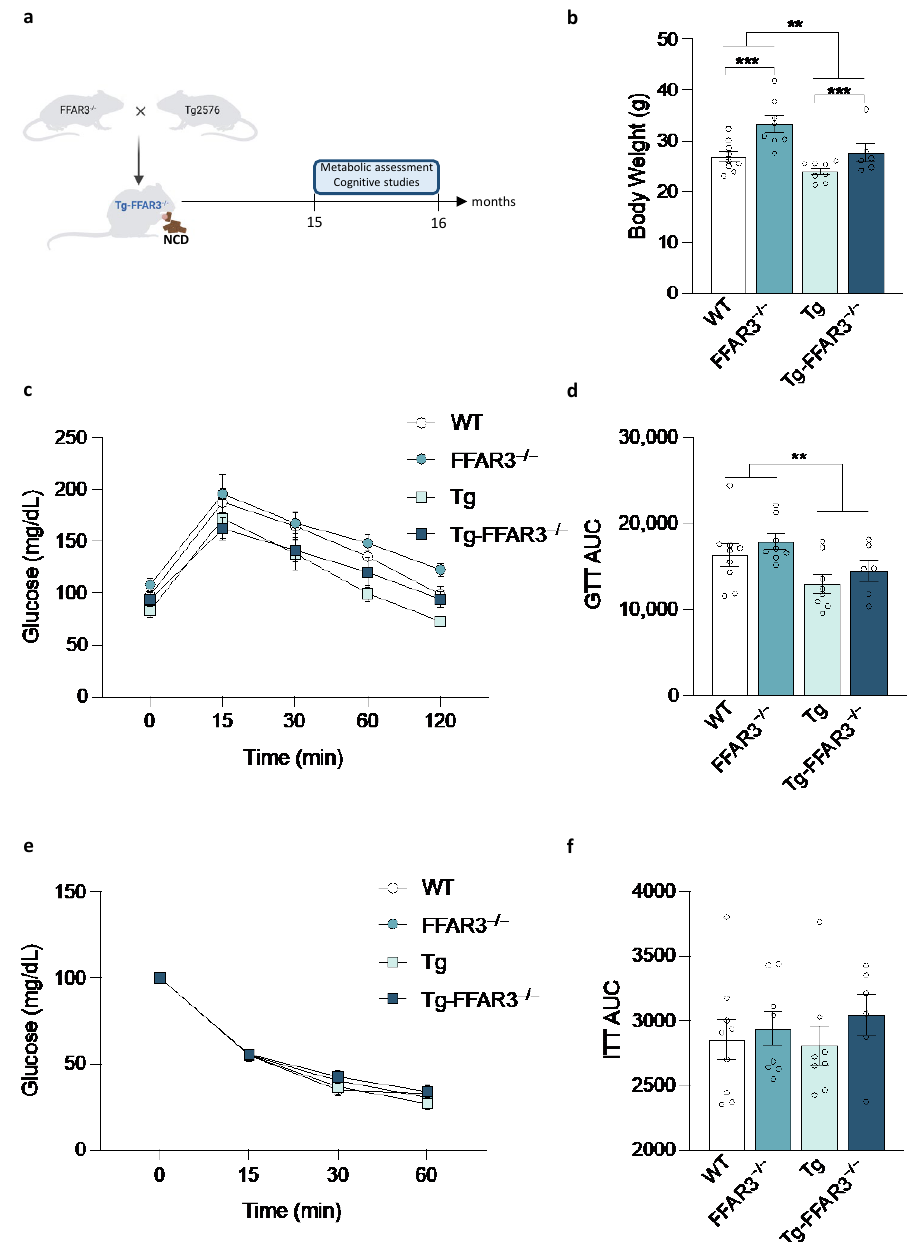
Figure 1. FFAR3 ablation induces body weight elevation in mice fed with normal chow diet (NCD). ( a ) Schematic representation of the strategy used to generate Tg2576 mice lacking FFAR3 and the subsequent metabolic assessment. ( b ) Body weight evaluation of wild type (WT), FFAR3 knockout (FFAR3 −/− ), Tg2576 (Tg) and Tg2576 FFAR3 knockout mice (Tg-FFAR3 −/− ). ( c ) Glucose tolerance test (GTT) and ( d ) the corresponding AUC quantification. ( e ) Insulin tolerance test (ITT) and ( f ) the corresponding AUC quantification. Results are expressed as mean ± SEM and circles in the subfigures represent each individual value ( n = 6–9 in each group). ** p < 0.01, *** p < 0.001, two-way ANOVA followed by Tukey.